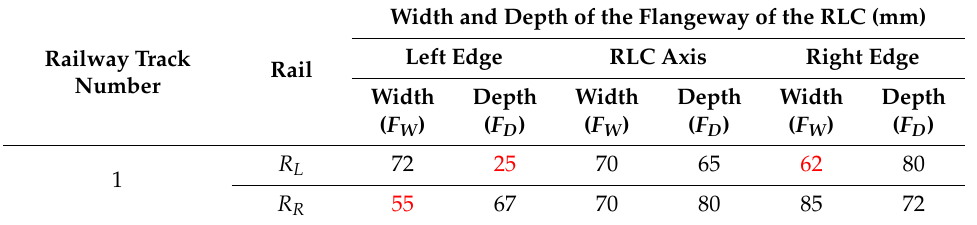
The red color indicates exceeded values. R L —Left rail; R R —Right rail.